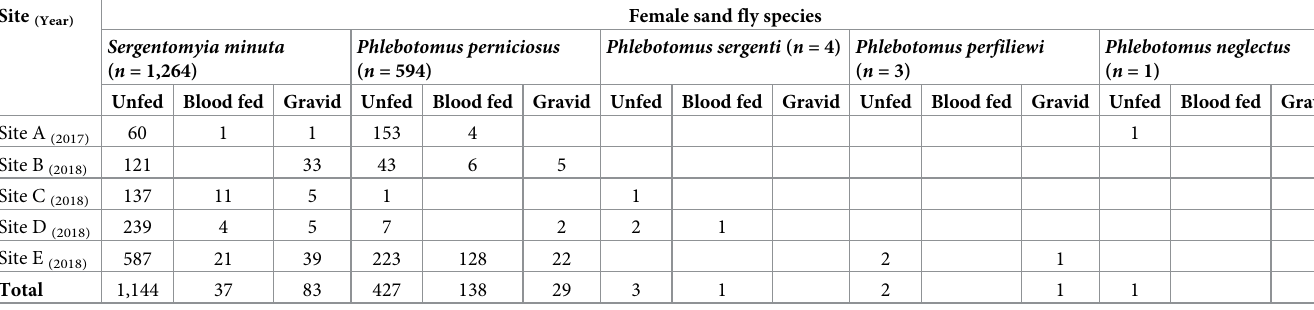
Table 2. Female sand flies sampled and molecularly analysed. Site